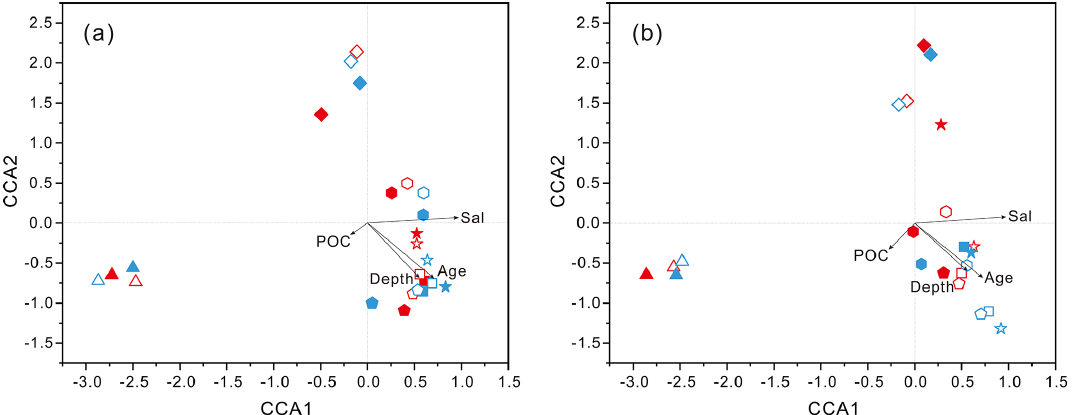
Figure 4. Results of CCA analysis to correlate several environmental factors including POC, seawater age, salinity and depth to PA and FL microbial communities collected from seawater columns of the South China Sea. (a) PA and FL bacteria; (b) PA and FL archaea. Triangle: 50m; rhombus: 200m; hexagon: 1000m; star: 2000m; square: 3000m; pentagon: 4000m. Blue color: J5 station; red color: G3 station. Filled: particle-attached fraction; open: free-living